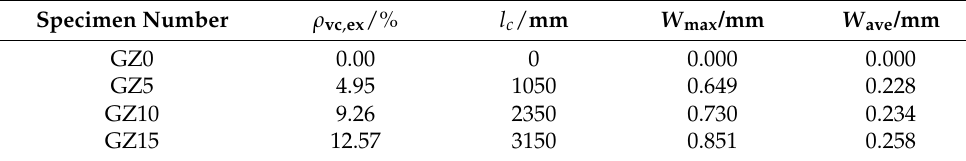
Table 3. Total length, maximum, and average width of corrosion-induced cracks. Specimen Number